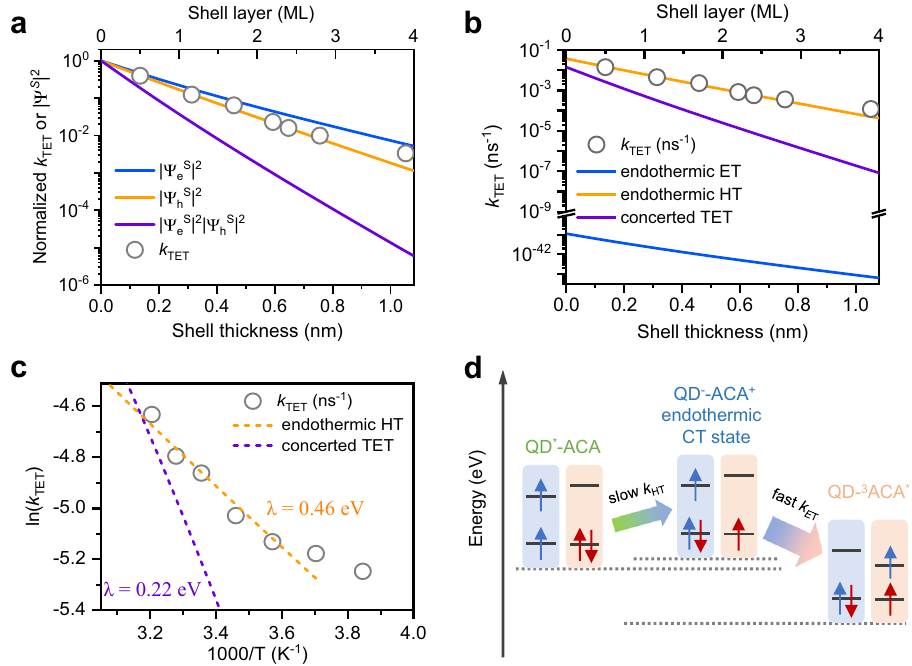
Fig. 4 Endothermic CT-mediated TET. a Comparison of experimental shell thickness-dependent TET rates (open circles) and calculated carrier probability density on QD surface (blue, orange, and purple lines for electron, hole, and their products, respectively). These quantities are rescaled by setting the values at 1 for zero shell thickness. b Comparison of experimental shell thickness-dependent TET rates (open circles) and calculated TET rates based on concerted (purple line) and endothermic hole-transfer (orange line) and electron transfer (blue line) mediated TET models. c Temperature-dependent TET rates in CdSe/2.2ZnS QD-ACA in hexane solution in 260 – 320 K (open circles) and Marcus theory fi tting using an endothermic hole-transfer-mediated TET model with reorganization energy of 0.46 eV (orange dash line). Concerted TET model with reorganization energy of 0.22 eV is also plotted for comparison (purple dash line). d Physical picture of endothermic hole-transfer (QD − -ACA + ) mediated TET in CdSe/ZnS QD-ACA constructs. k HT and k ET stand for the rates of hole- and electron transfer steps, respectively. Because k HT ≪ k ET , the overall TET rate is dictated by k HT